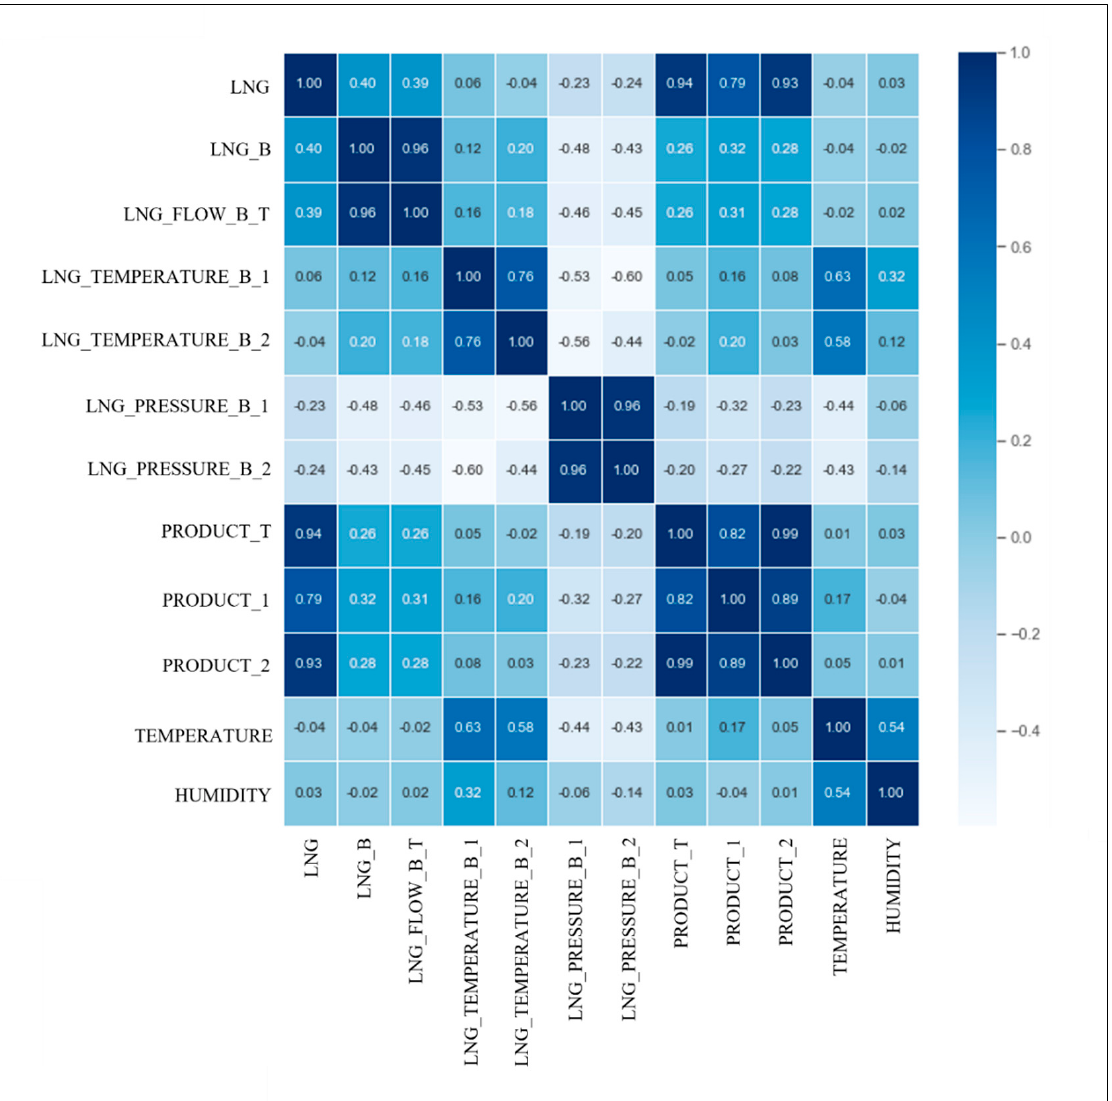
Figure 7. Correlations between variables for the LNG consumption prediction. Table 7. Correlations with the LNG consumption of the day.